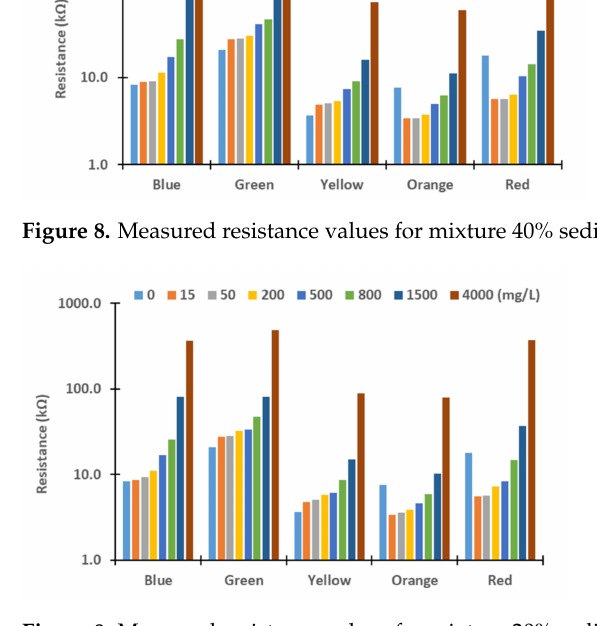
Figure 9. Measured resistance values for mixture 20% sediment and 80%